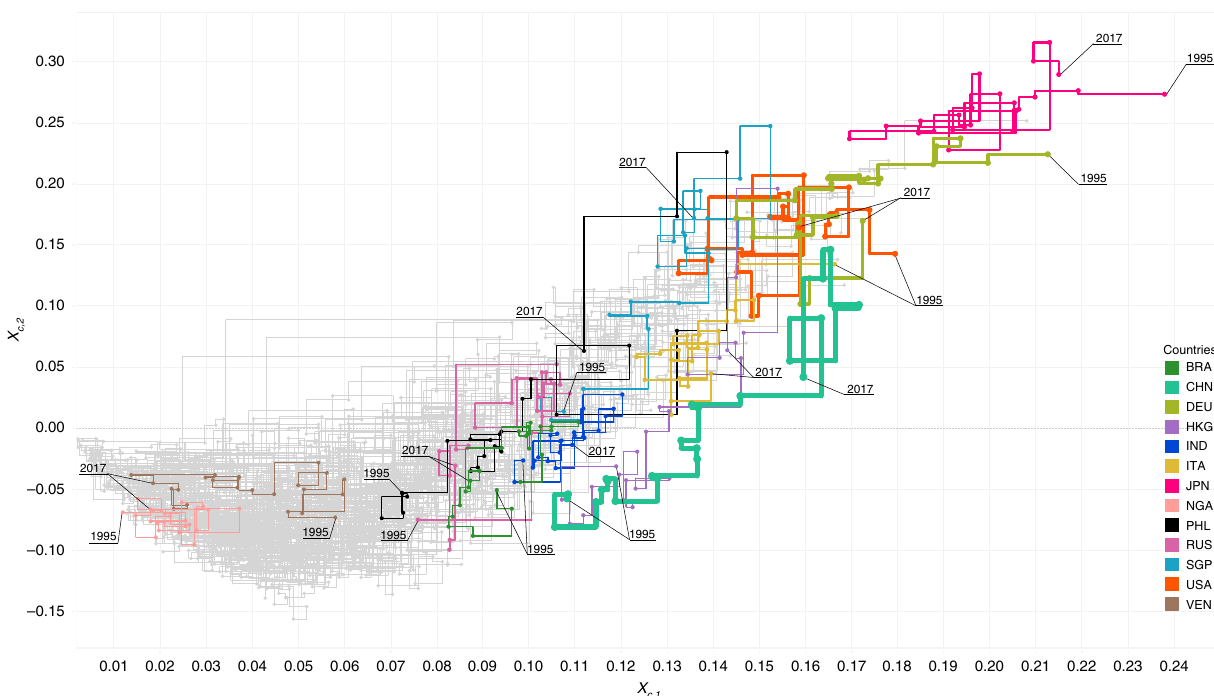
Fig. 2 Countries ’ trajectories in the GENEPY plane. The values of the fi rst eigenvector X c ,1 are on the x -axis, whilst on the y -axis the values of the second eigenvector X c ,2 are found. The eigenvectors are normalised such that their Frobenius norm is unitary, i.e., trajectories of Brasil (BRA), China (CHN), Germany (DEU), Hong Kong (HKG), India (IND), Italy (ITA), Japan (JPN), Nigeria (NGA), Philippines (PHL), Russia (RUS), Singapore (SGP), United States of America (USA) and Venezuela (VEN), against the background created by trajectories of all other countries in grey. Line width re fl ects the countries ’ share of world exports in monetary value during 2017. To improve the readability of the plot, the paths from one point to another were forced to follow right-angled movements. The fi gure has been produced with Tableau Public